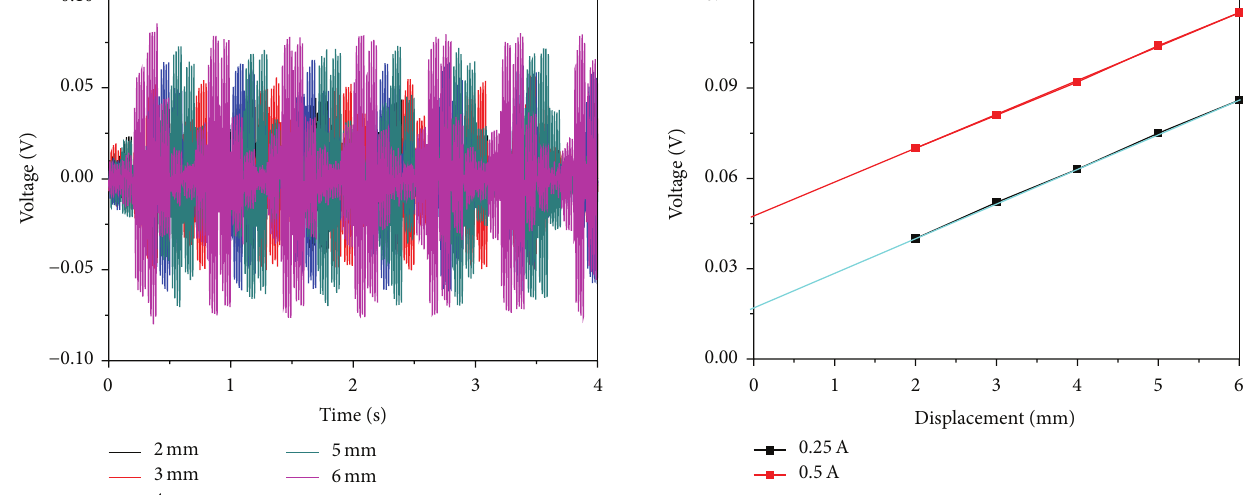
Figure 13: Self-induced voltage under different damper displace- ment input as the DC input was set as 0.25 A.